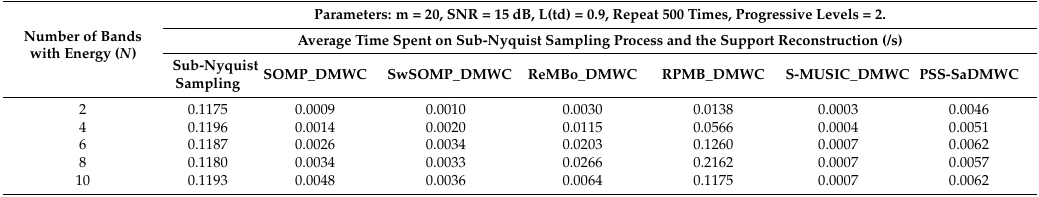
Table 6. Average time spent during sub-Nyquist sampling and reconstruction with different N .